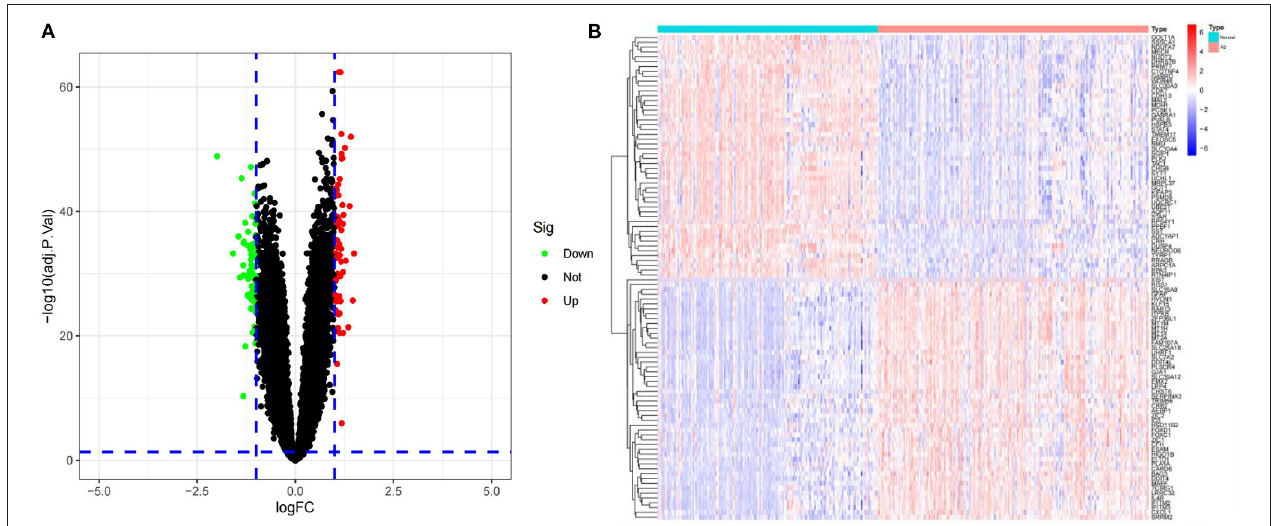
FIGURE 2 | (A) Volcano plots of all DEGs in the training dataset. Green spots represent down-regulated genes, while red spots represent up-regulated genes. (B) All of the DEGs are represented as a heatmap. Up- and down-regulated genes are marked on the map. Red samples indicate AD, while blue samples indicate normal. Red blocks indicate high-expressed genes, and blue blocks low-expressed